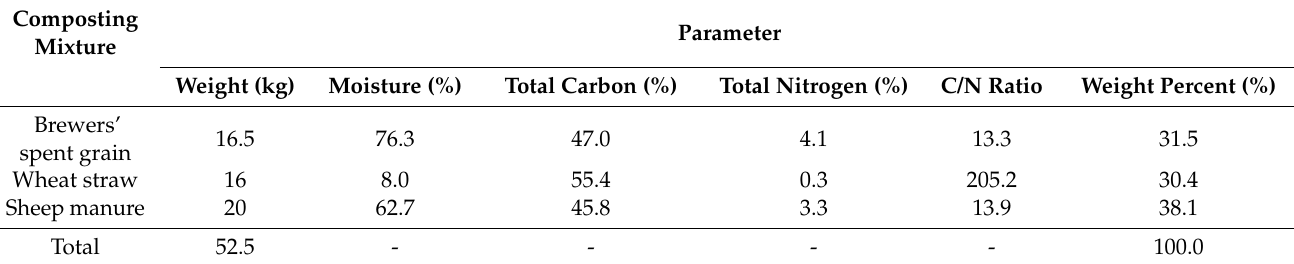
Table 3. Compositions of a hypothetical sheep manure composting